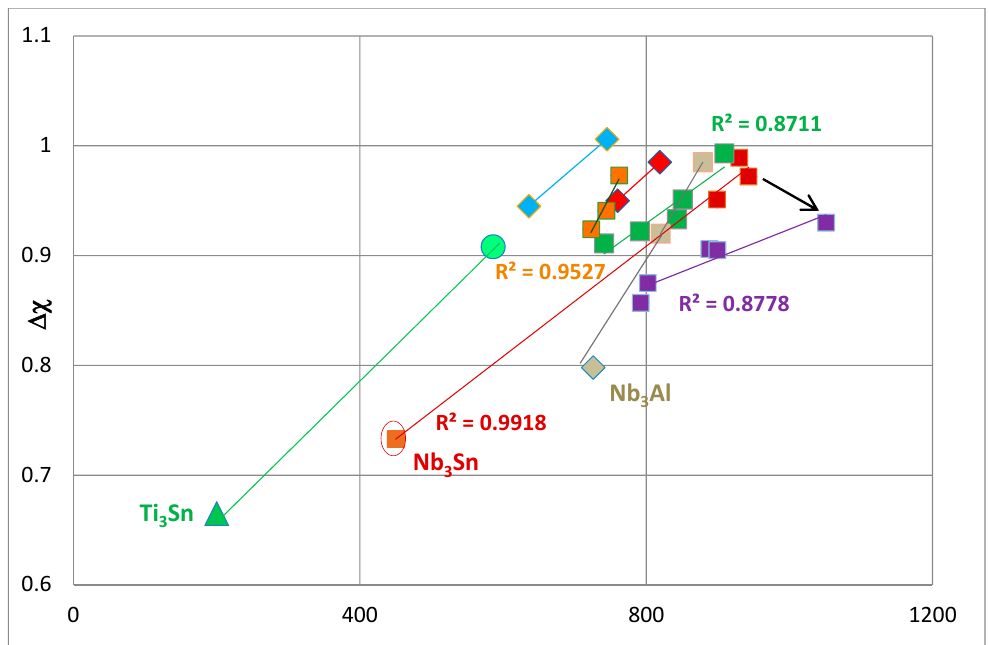
Figure 7. ∆χ versus Vickers hardness (HV) of A15–Nb 3 X and Ti 3 Sn. Dark red squares represent data for Nb 3 Sn and Nb 3 (Sn,Si); the encircled data point represents unalloyed Nb 3 Sn, green triangles represent unalloyed Ti 3 Sn, tan diamonds represent unalloyed Nb 3 Al, green squares represent (Nb,Ti,Hf) 3 (Si,Sn), (Nb,Cr,Hf) 3 (Si,Sn) and (Nb,Ti,Cr,Hf) 3 (Si,Sn), blue diamonds represent (Nb,Ti) 3 (Si,Sn), red diamonds represent (Nb,Hf) 3 (Si,Sn), orange squares represent (Nb,Ti,Fe) 3 (Si,Sn), purple squares represent (Nb,Ti,Hf) 3 (Si,Sn,Al) and (Nb,Ti,Cr,Hf) 3 (Si,Sn,Al), tan squares represent (Nb,Hf) 3 (Si,Sn,Al) and green circles represent Ti rich (Nb,Ti,Fe) 3 (Si,Sn).